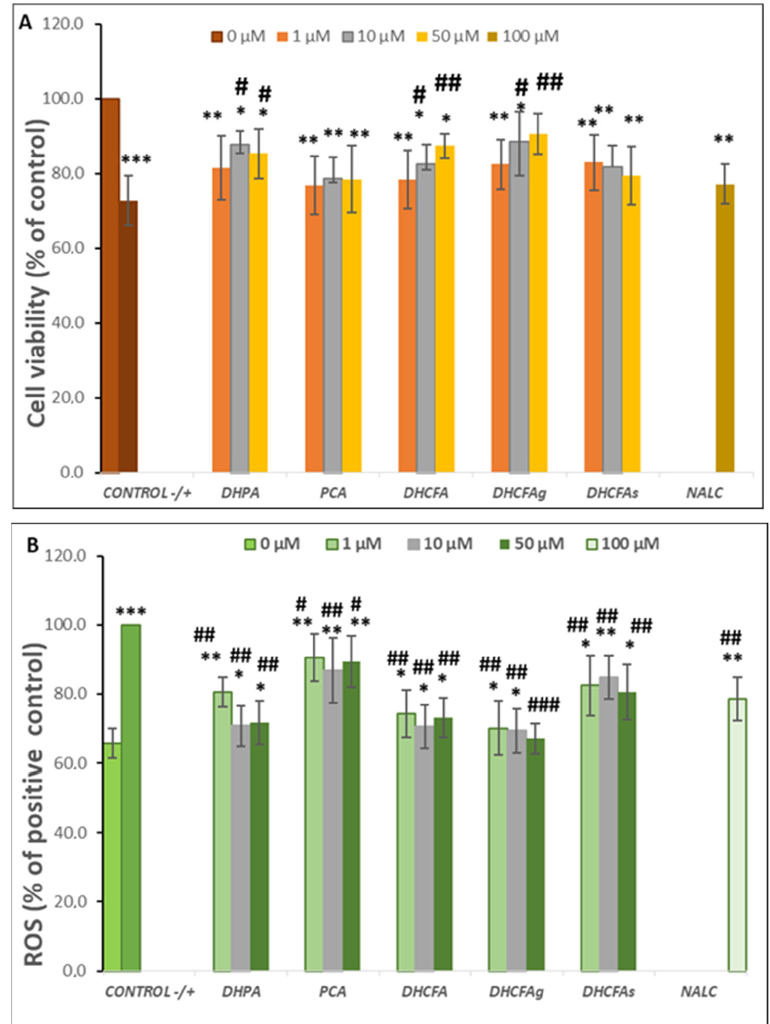
Figure 4 . Neuroprotective effects of microbial-derived phenolic acids (DHPA, PCA, and DHCFA) and conjugated derivatives (DHCFAg and DHCFAs) (1, 10, and 50 μ M) on SH-SY5Y cells under LPS (100 ng/mL) inflammation damage for 24 h of co-incubation. Results of cell viability (% of the control) ( A ) and ROS generation (% of the positive control) ( B ) in LPS-stimulated cells. *, **, *** Significant differences ( p < 0.05, p < 0.01, p < 0.001, respectively) with respect to the control ( − ); # , ## , ### Significant differences ( p < 0.05, p < 0.01, p < 0.001, respectively) relative to the positive control (+).